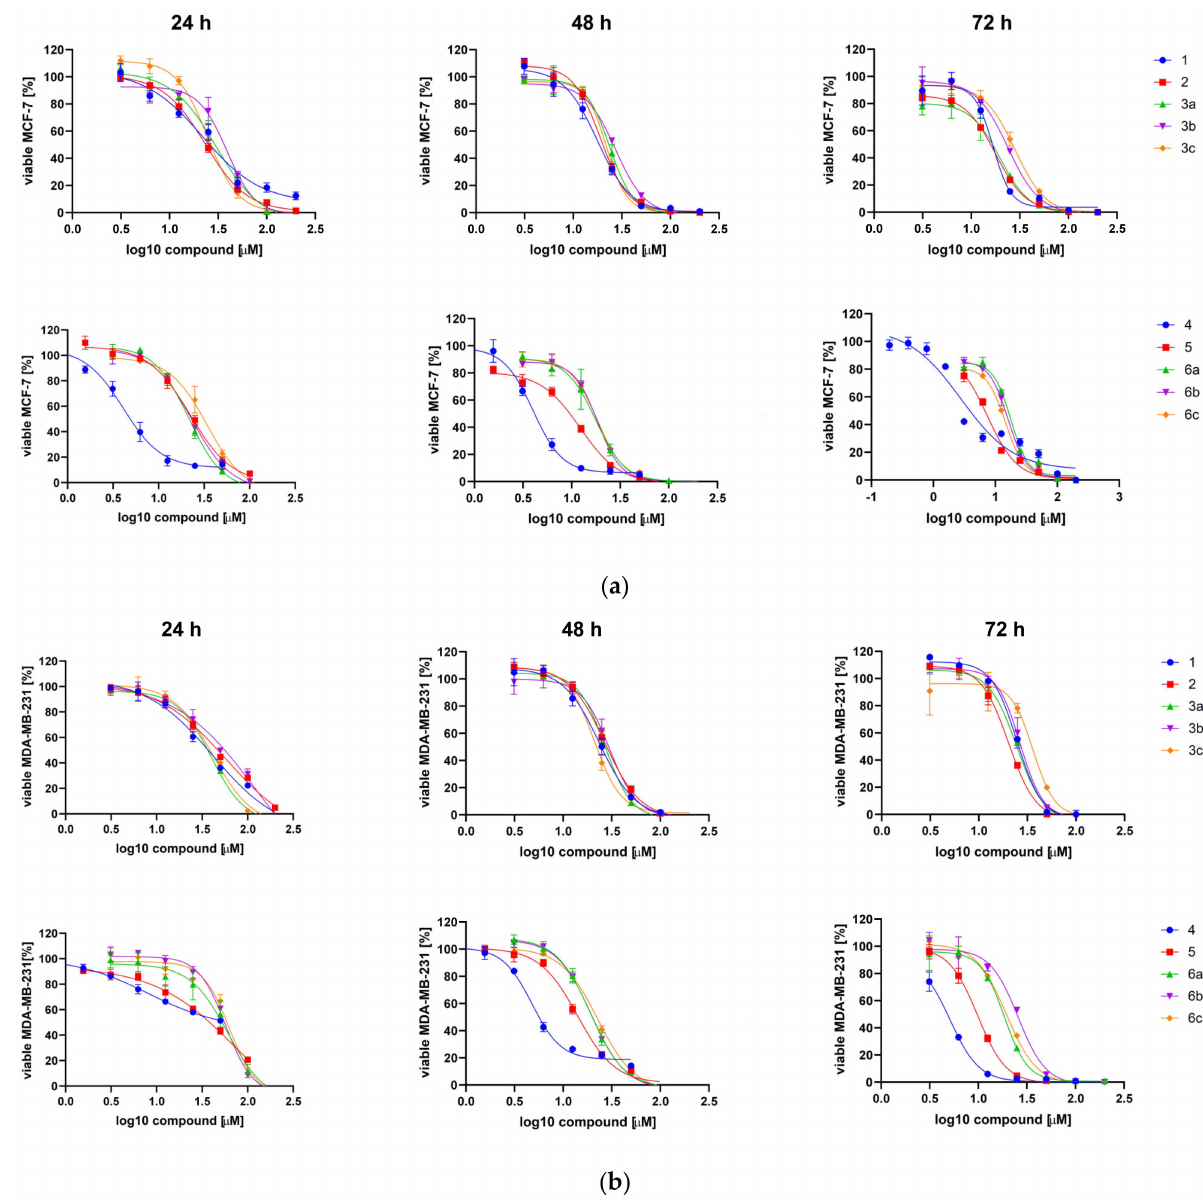
Figure 3. Sigmoidal dose–response curves for compounds 1 , 2 , 3a – c , 4 , 5 and 6a – c determined for MCF-7 ( a ) and MDA- MB-231 ( b ) after 24 h, 48 h and 72 h of treatment. Plots were generated by GraphPad Prism after fitting the MTT data to sigmoidal dose response equation Y = 100/(1 + 10ˆ((LogIC 50 − X) *